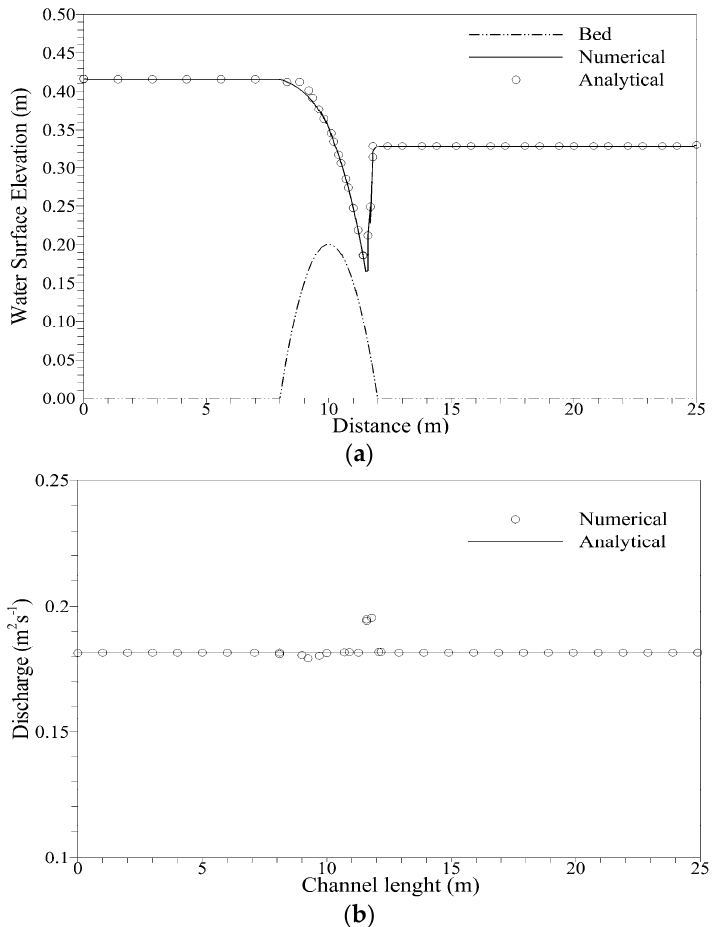
Figure 9. Comparison of water surface elevation for transcritical flow without a shock.